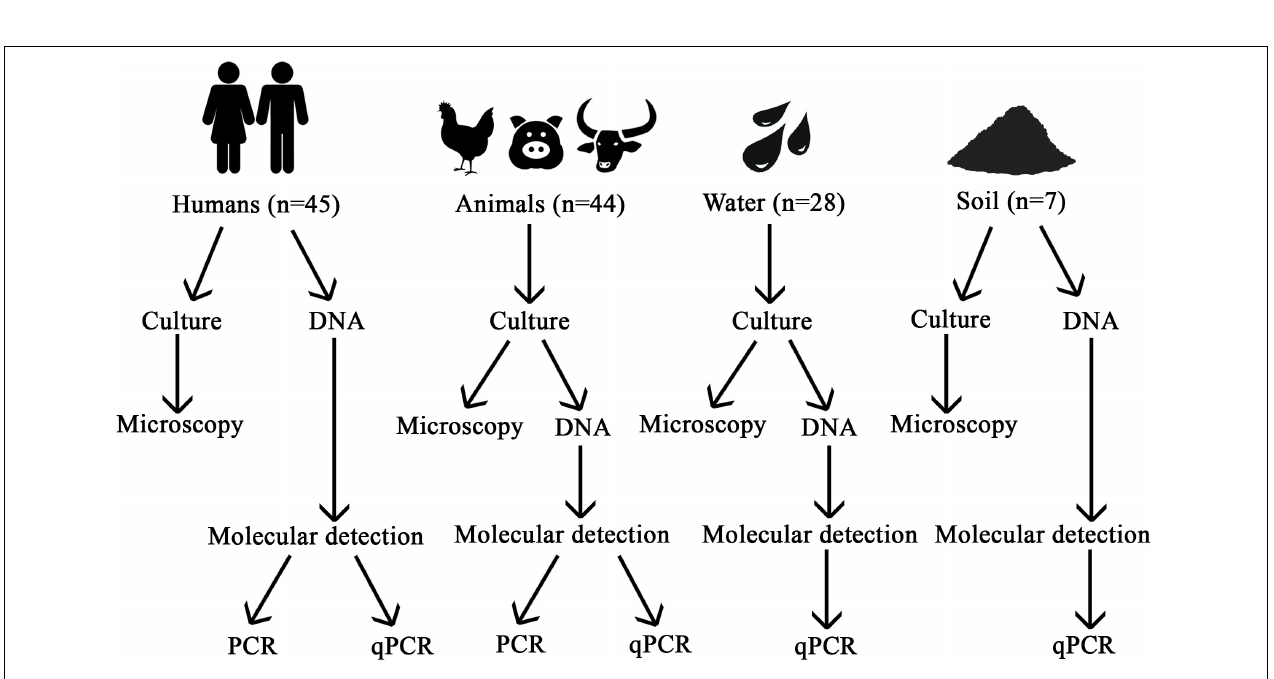
FIGURE 2 | Flow chart of the methodology used in this